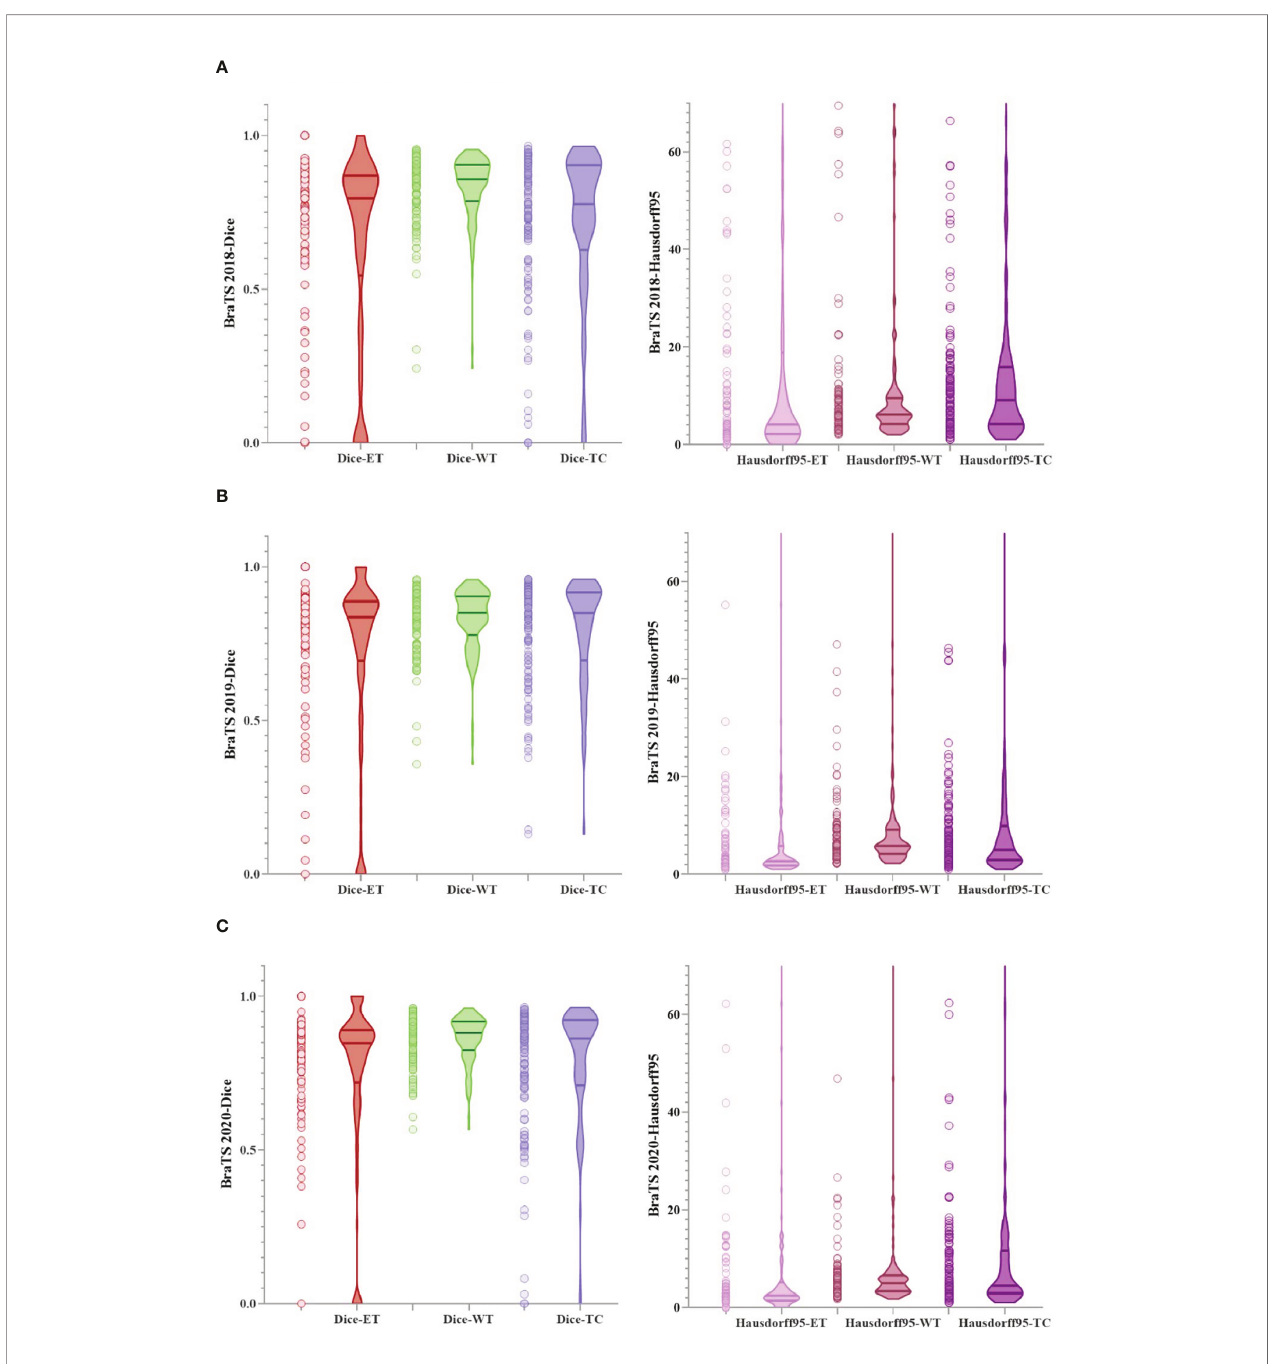
FIGURE 6 | The result of the evaluation metrics of the validation set. (A) Dice and Hausdorff95 at BraTS 2018, (B) Dice and Hausdorff95 at BraTS 2019 and (C) Dice and Hausdorff95 at BraTS